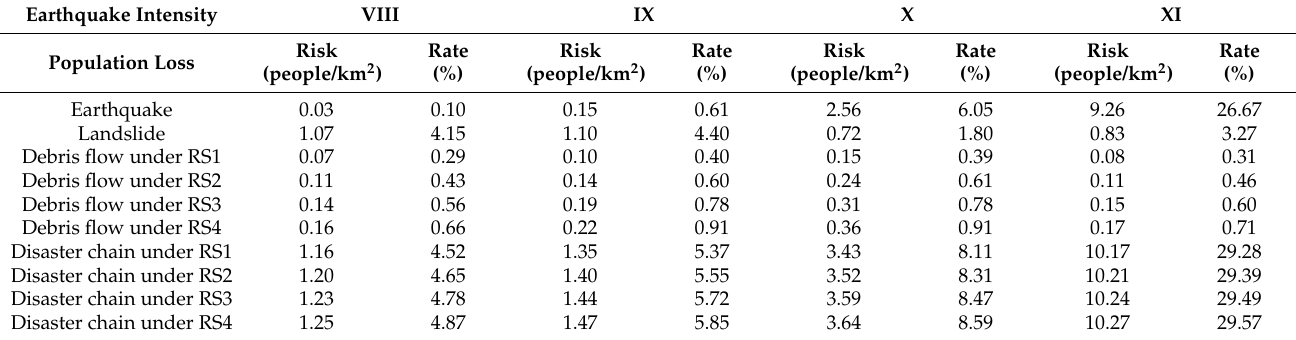
Table 4. Population loss risks and rates caused by a disaster chain under different earthquake intensities. Earthquake Intensity